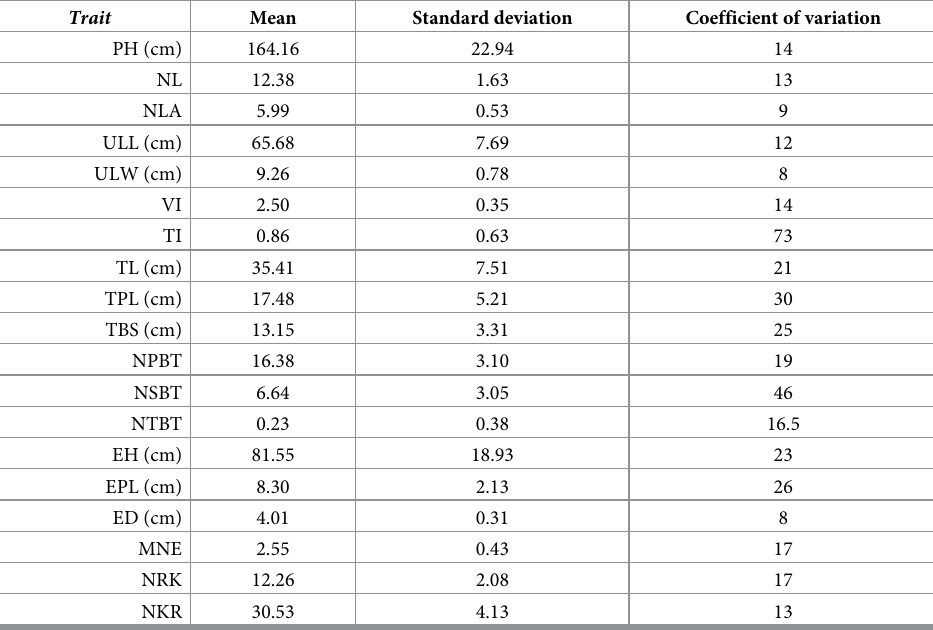
Table 1. Quantitative trait variation in 30 maize accessions from Northwestern Argentina (NWA).